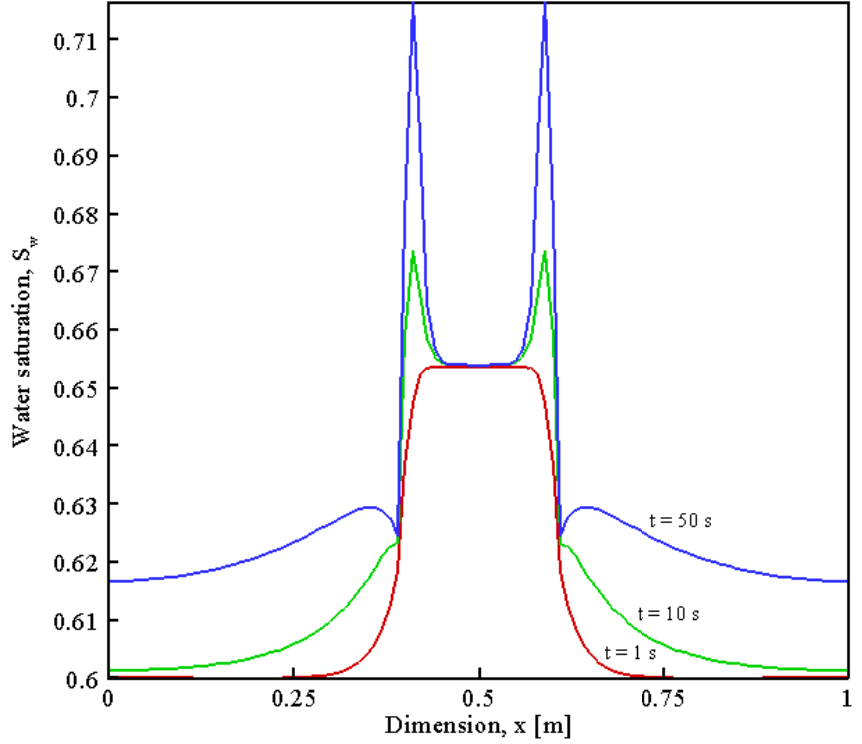
Figure 7. Hydrate saturation distribution S h versus dimension x at the different moments of time t = 1, 10, 50s in the three-phase flow.